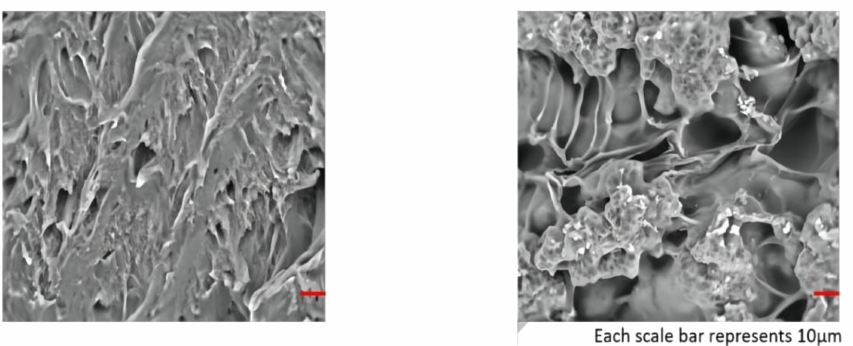
Figure 15. SEM images exhibiting the microstructure of F127DA/PLGA hydrogels ( left ) and F127DA/PLGA/GO hydrogels ( right ). Reprinted with permission from Ref. [132]. Copyright 2019, Dai,